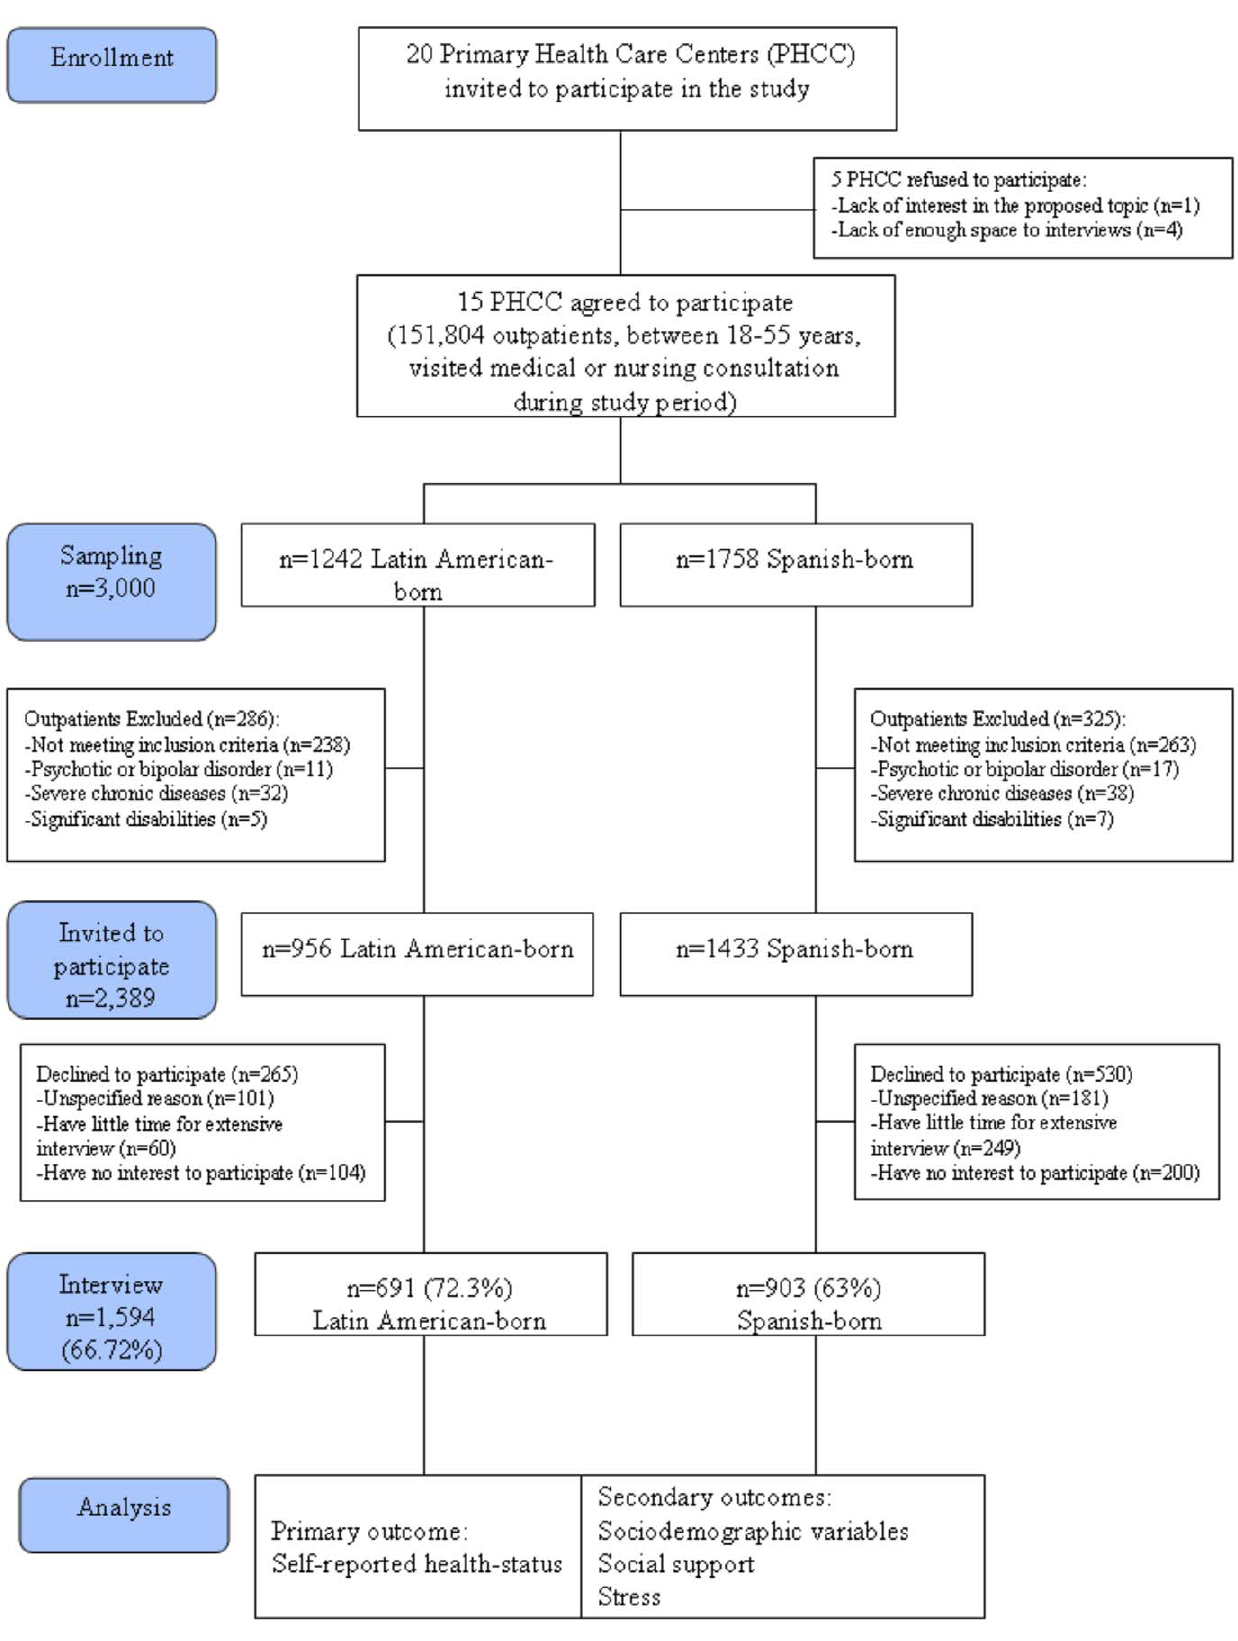
Figure 1. Flow diagram of participants.